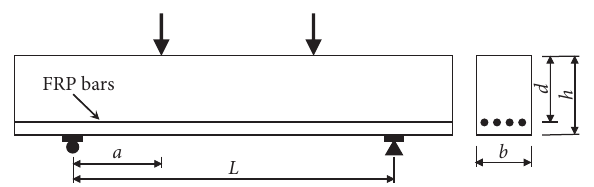
Figure 1: FRP bar reinforced concrete beams without web